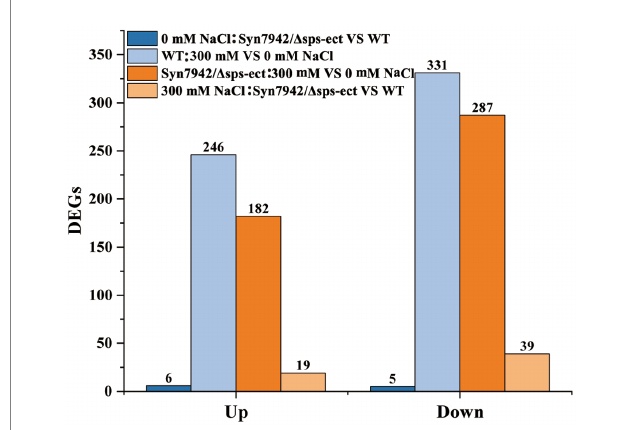
FIGURE 4 DEGs identified in transcriptomic analysis. WT: 300 mM VS 0 mM NaCl indicates the DEGs of WT under 300 mM NaCl compared with 0 mM NaCl condition; Syn7942/ Δ sps-ect: 300 mM VS 0 mM NaCl indicates the DEGs of Syn7942/ Δ sps-ect under 300 mM NaCl compared with 0 mM NaCl condition; 0 mM NaCl: Syn7942/ Δ sps-ect VS WT indicates the DEGs of Syn7942/ Δ sps-ect grown in 0 mM NaCl condition compared to WT; 300 mM NaCl: Syn7942/ Δ sps-ect VS WT indicates the DEGs of Syn7942/ Δ sps-ect grown in 300 mM NaCl condition compared to WT.